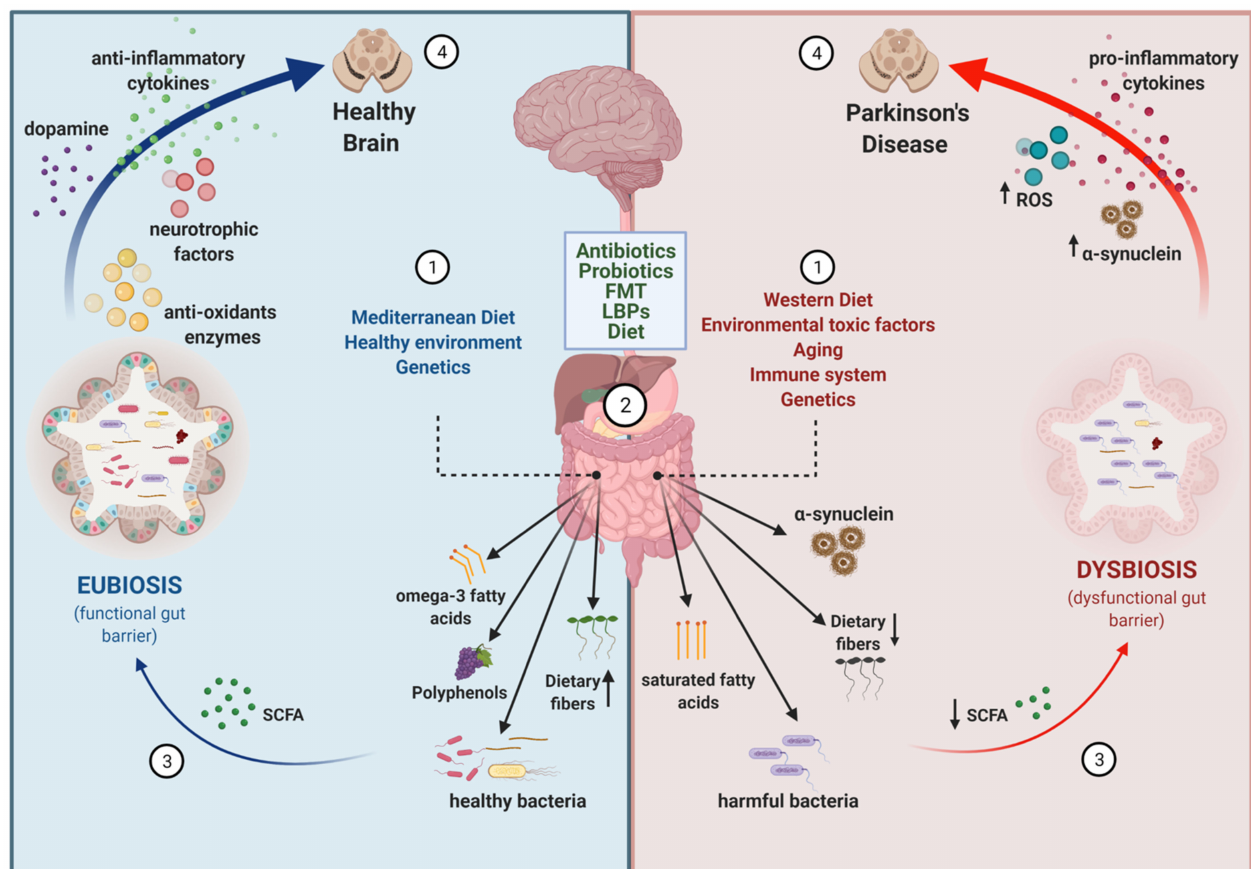
Figure 1. Disease-modifying strategies based on the gut microbiota. (1) The gut microbiota composition is influenced by several intrinsic (i.e., genetics, aging and immune system function) and extrinsic factors, including dietary habits (e.g., Mediterranean diet vs. Western diet) and environmental conditions (e.g., healthy environment vs pesticides/polluted environment). (2) Several strategies can be used to modify the composition of the gut microbiota to revert a dysbiotic condition: antibiotics, probiotics, fecal microbiota transplants (FMT), live biotherapeutic products (LBP), and dietary factors. (3) As a result, the balance between healthy/harmful bacteria, the presence of dietary fibers, the levels of metabolites with anti/pro-oxidant and anti/pro-inflammatory properties (e.g., omega-3 fatty acids, polyphenols, short chain fatty acids (SCFA), saturated fatty acids), and the aggregation of proteins like α -synuclein in the gut will be modified. (4) Because of the existing communication between the gut and the brain, these changes in the gut may have a direct impact on brain function through different mechanisms: levels of neurotransmitters, cytokines, reactive oxygen species (ROS), neurotrophic factors, and aggregation of α -synuclein. Overall, changes of the gut microbiota composition can have a beneficial or detrimental impact on the neurodegenerative process occurring in Parkinson’s